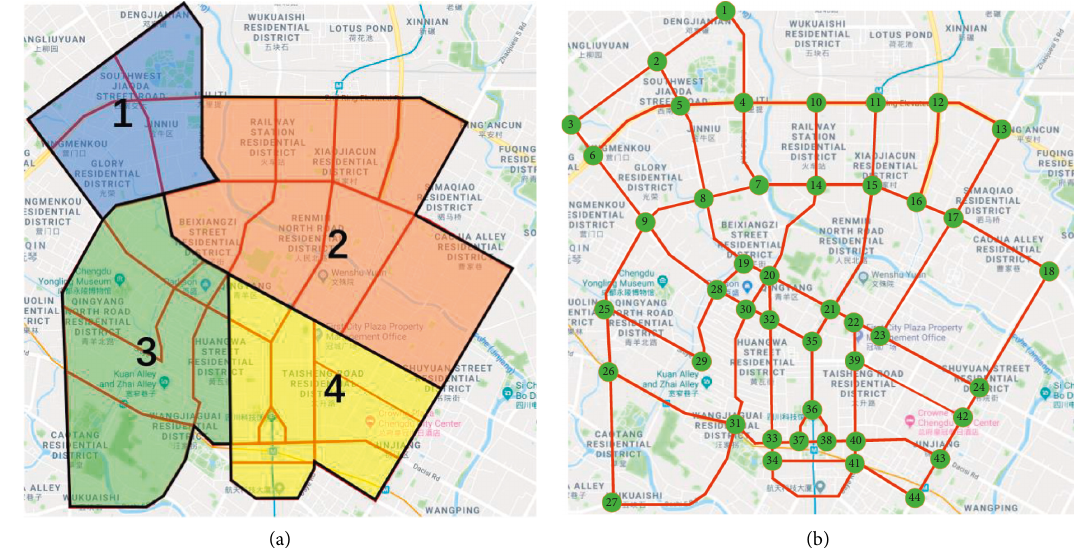
Figure 4: The topology of the experimental network. (a) Regional representation (b) Link-level